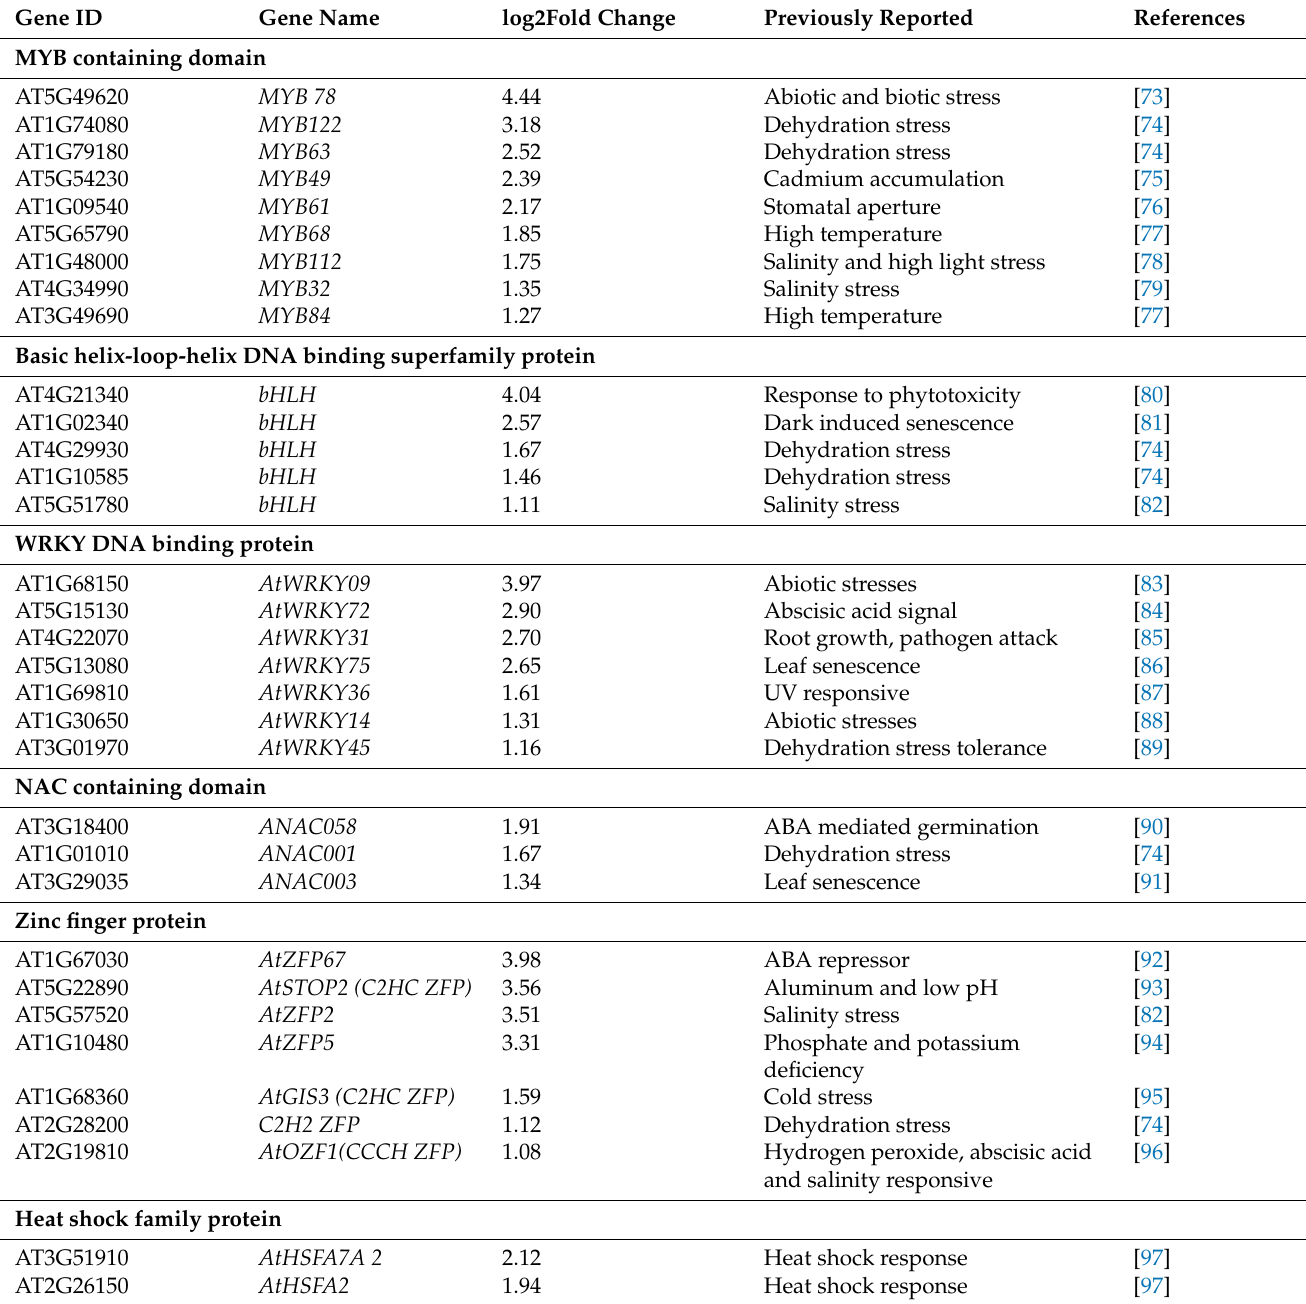
Table 2. List of transcription factors (TFs) involved in abiotic stresses regulation and signaling that were more upregulated in Cu-chl NaCl compared to NaCl.